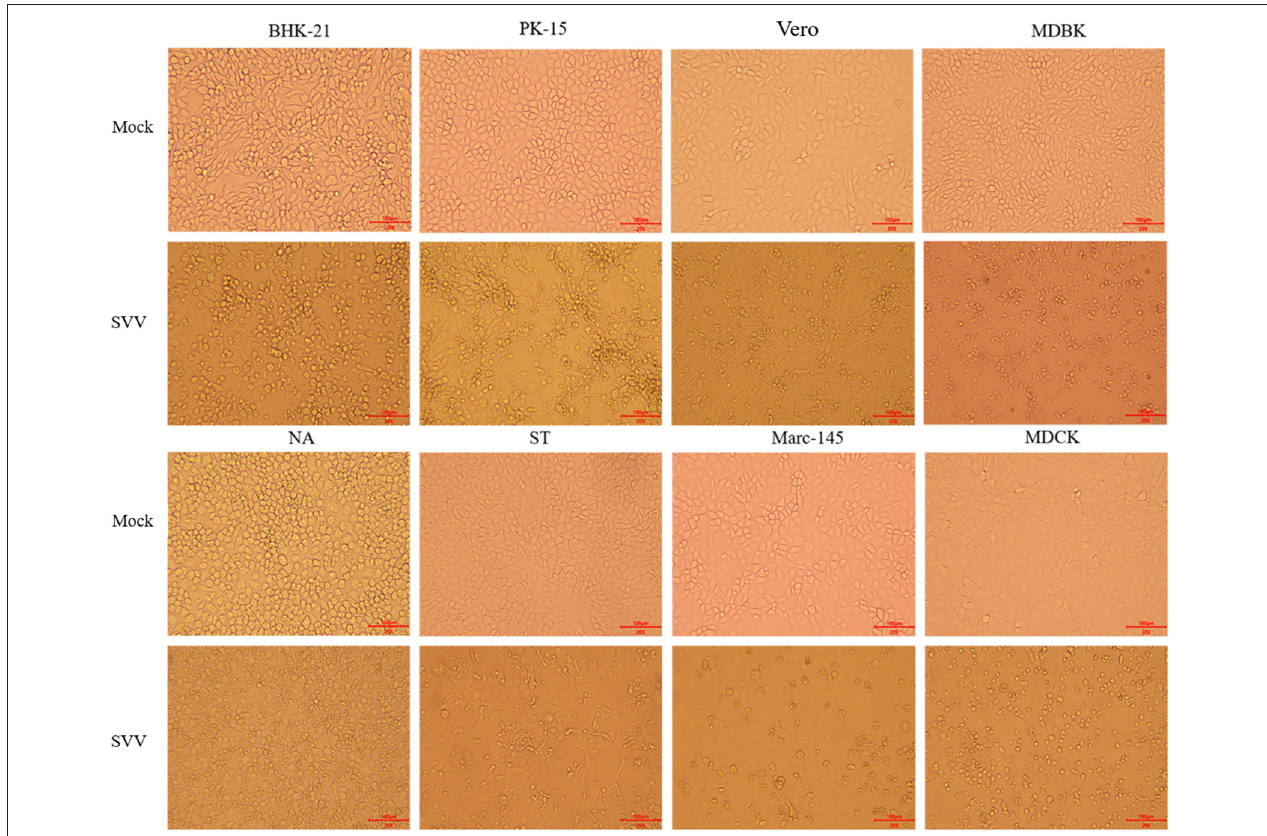
FIGURE 1 | Image of virus isolation with eight different types of cells. The virus was cultured in eight different types of cells, BHK-21 and NA cells, PK-15 and ST cells, Vero and Marc-145 cells, MDBK cells, and MDCK cells. The obvious cytopathic effect, CPE (20 × ), produced cellular rounding, refraction, cell death, shedding, and floating with BHK-21, PK-15, ST, and Vero cells after 36h. However, the similar phenomena were not occurred until 96h in NA cells, Marc-145 cells, and MDBK cells. The virus cannot be cultured for more than four passages with MDCK cells. “Mock” means the negative control cells, and “SVV” means positive control cells that virus